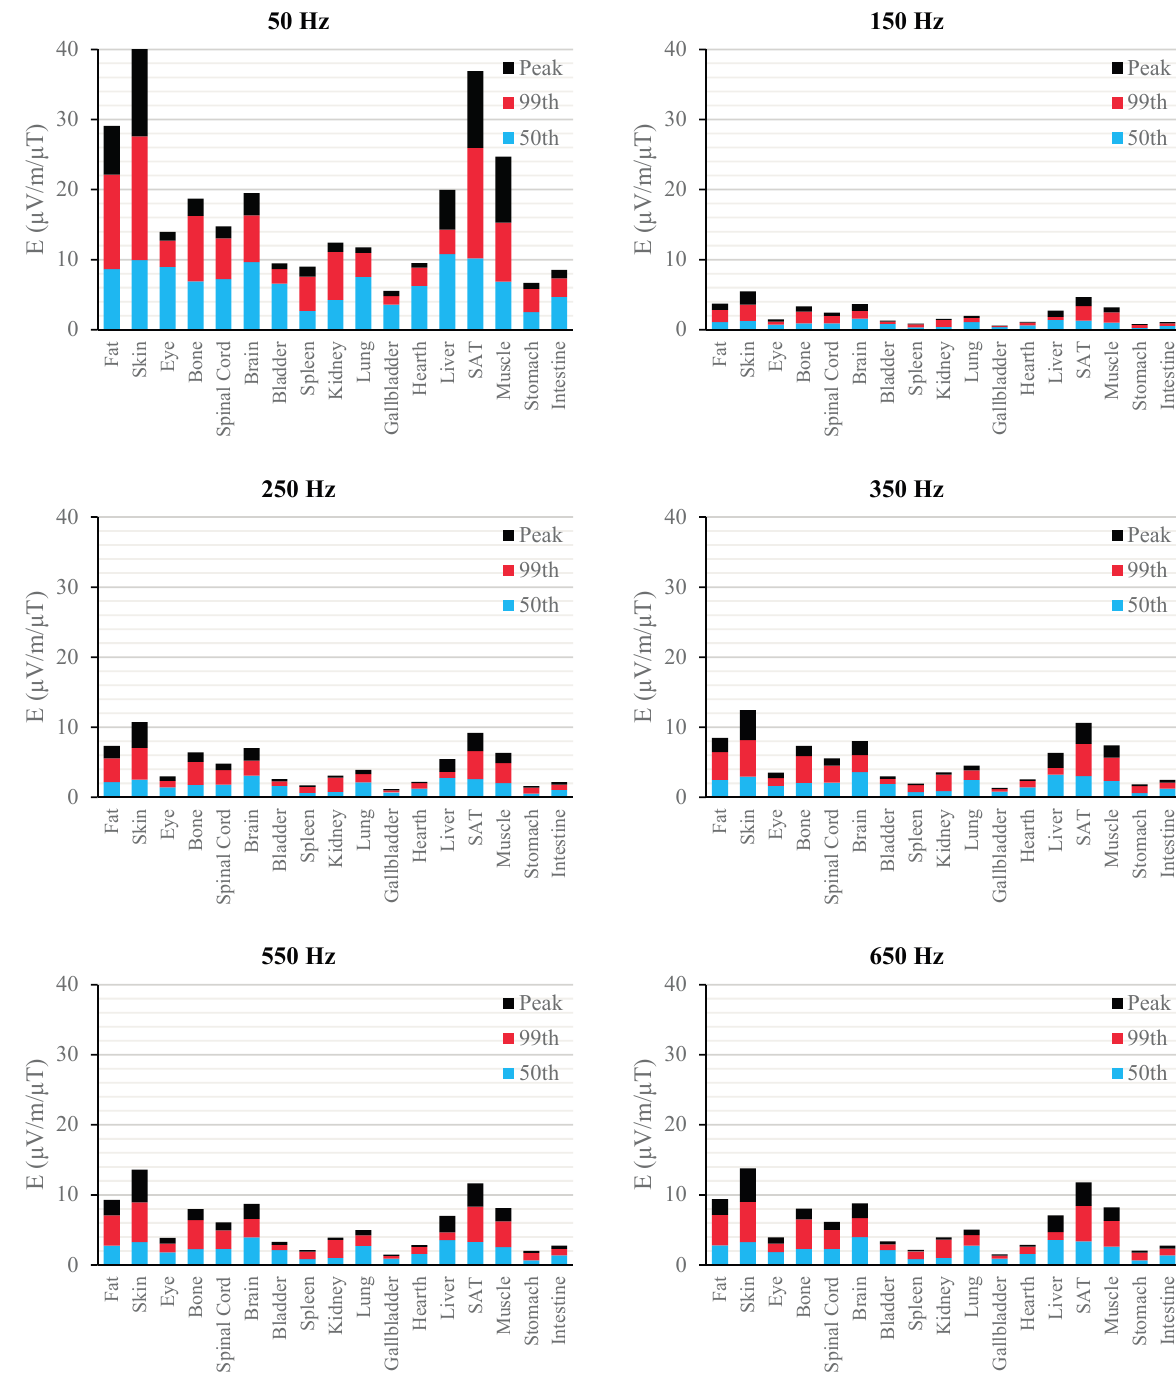
Figure 4. E ( μ V/m) per μ T of 50 Hz B peak induced in foetal tissues at 7 mGA for all the harmonic frequencies considering the standard EN 50160 for the LV&MV power supply networks. The bars indicate the E 50th (blue), the E 99th (red) percentiles and the E peak (black) of each